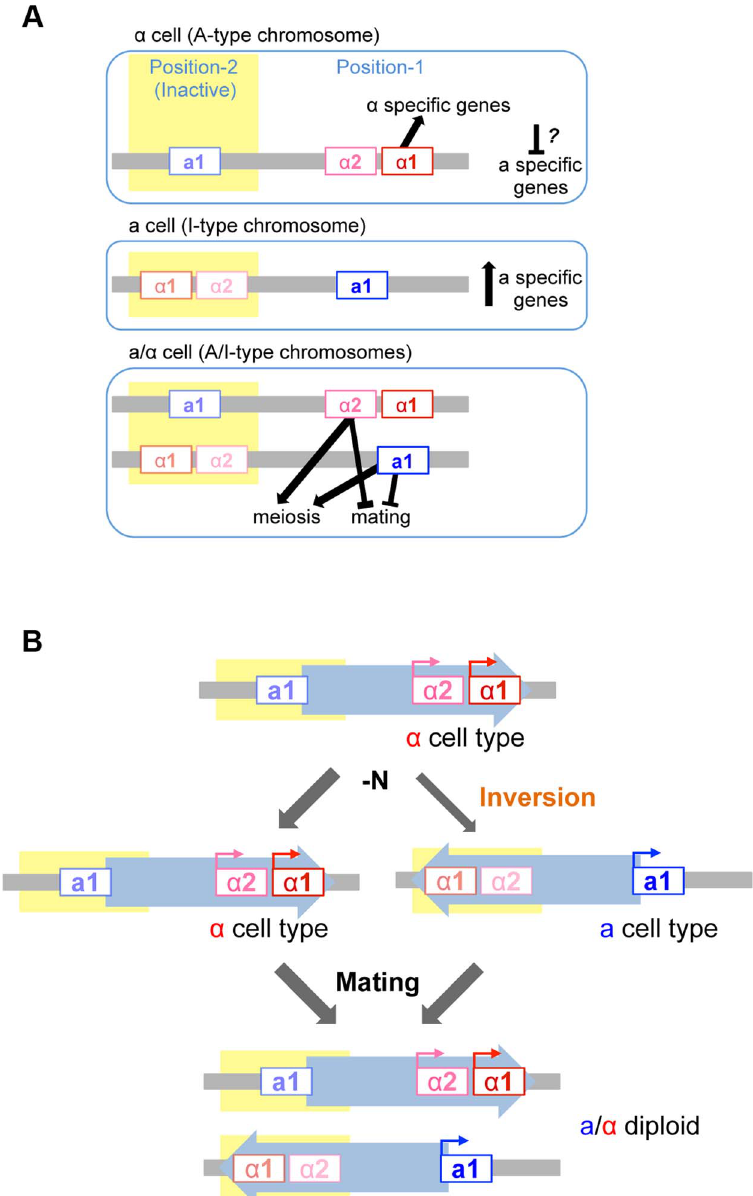
Figure 7. Model of mating type regulation in H.polymorpha . (A) Function of mating type genes in establishing mating type identity. (B) Model of homothallism in H. polymorpha